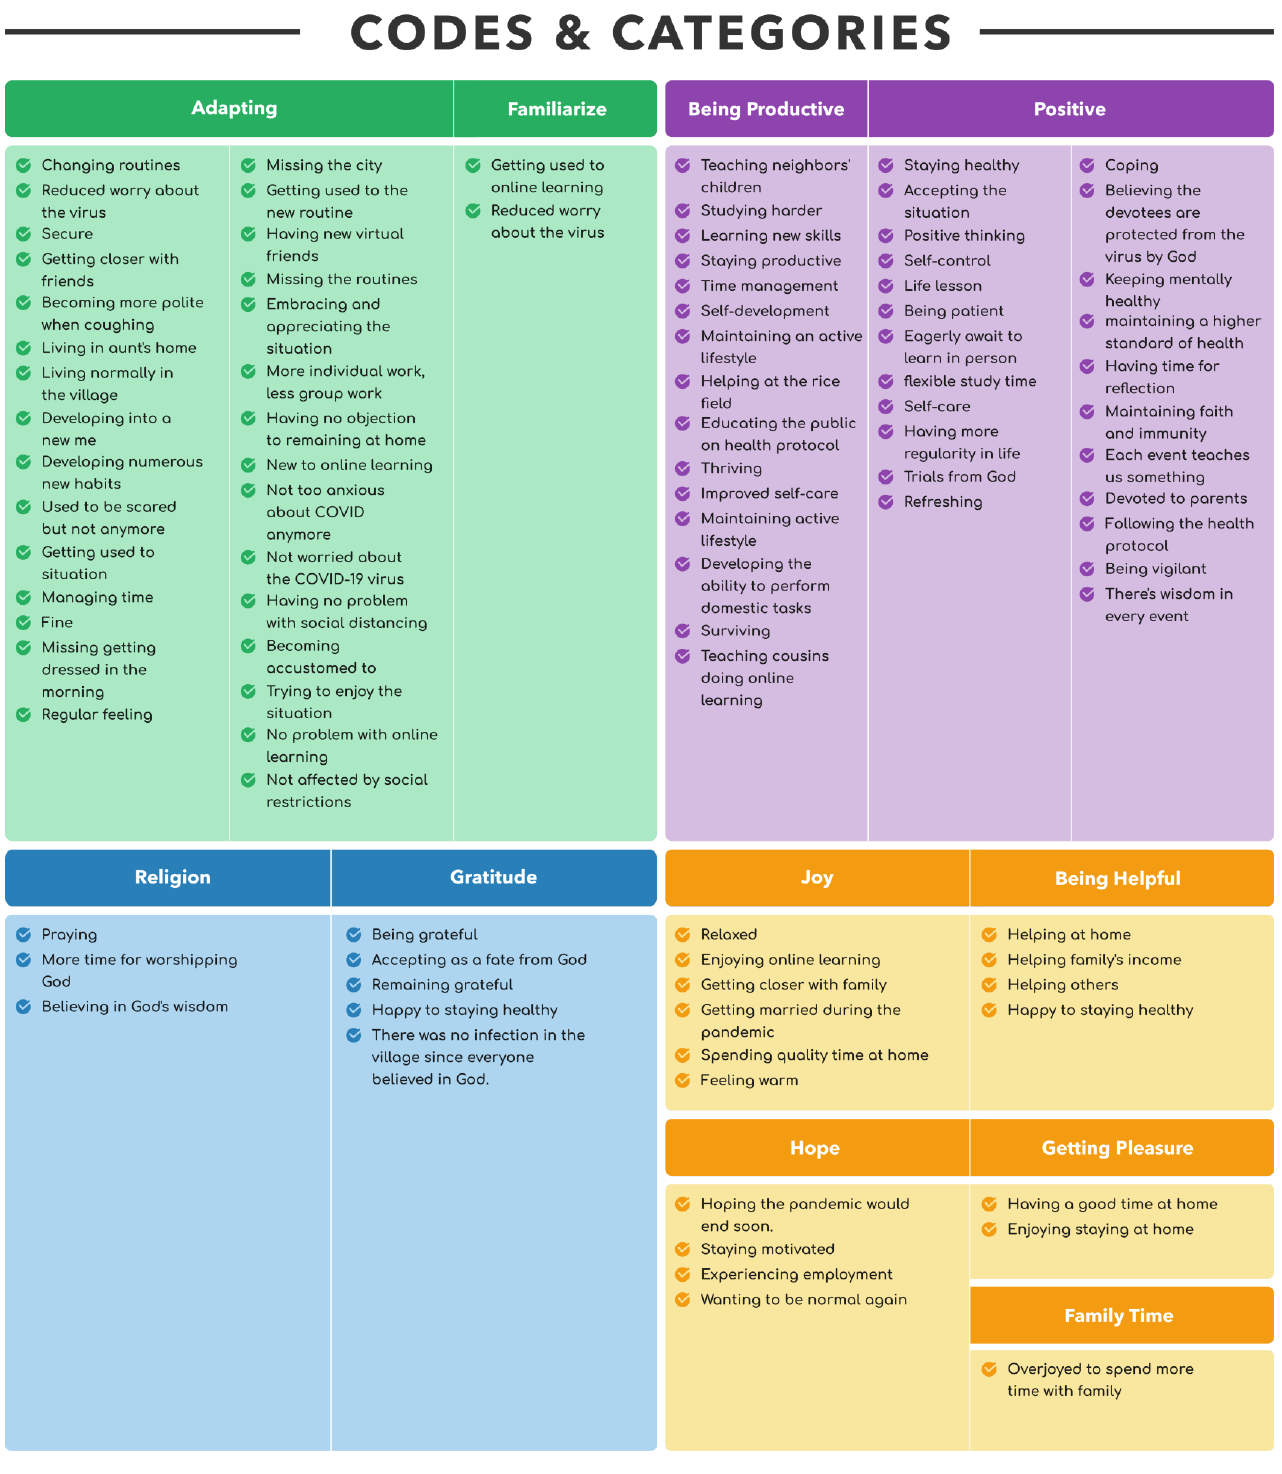
Figure 3. Positive codes and categories.